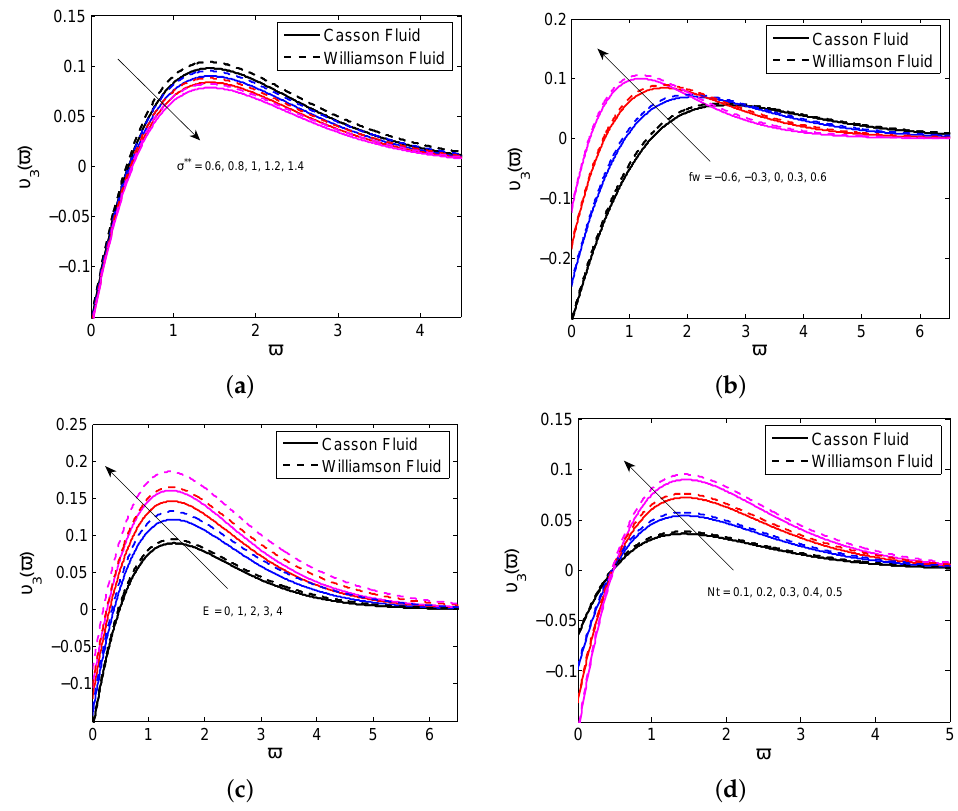
Figure 4. The nanoparticle concentration for various values of σ ∗∗ ( a ), fw ( b ), E ( c ) and Nt ( d ).